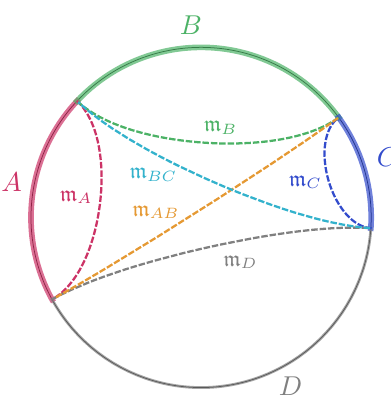
Figure 1 . An example of partitioning of the boundary space into regions (thick curves) A , B , C , and the complement ABC (cid:17) D , as labeled. The corresponding minimal surfaces (dashed curves) for these 4 regions, along with those for AB and BC are also indicated. (In this and subsequent plots, we plot the Poincare disk in global coordinates described by constant t slice of (cid:2) (cid:3) (cid:0) dt 2 + d(cid:26) 2 + sin 2 (cid:26) d’ 2 with (cid:26) = (cid:25)= 2 corresponding to the boundary.) ds 2 = 1 cos 2 (cid:26) in its homology class, namely m and m = m in the case of (1.3), or m and m B D ABC A C